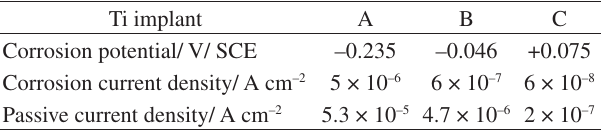
Table 2. Corrosion potential, corrosion current density and passive current density (measured at 1 V/SCE) of the three different Ti implants in artificial saliva.